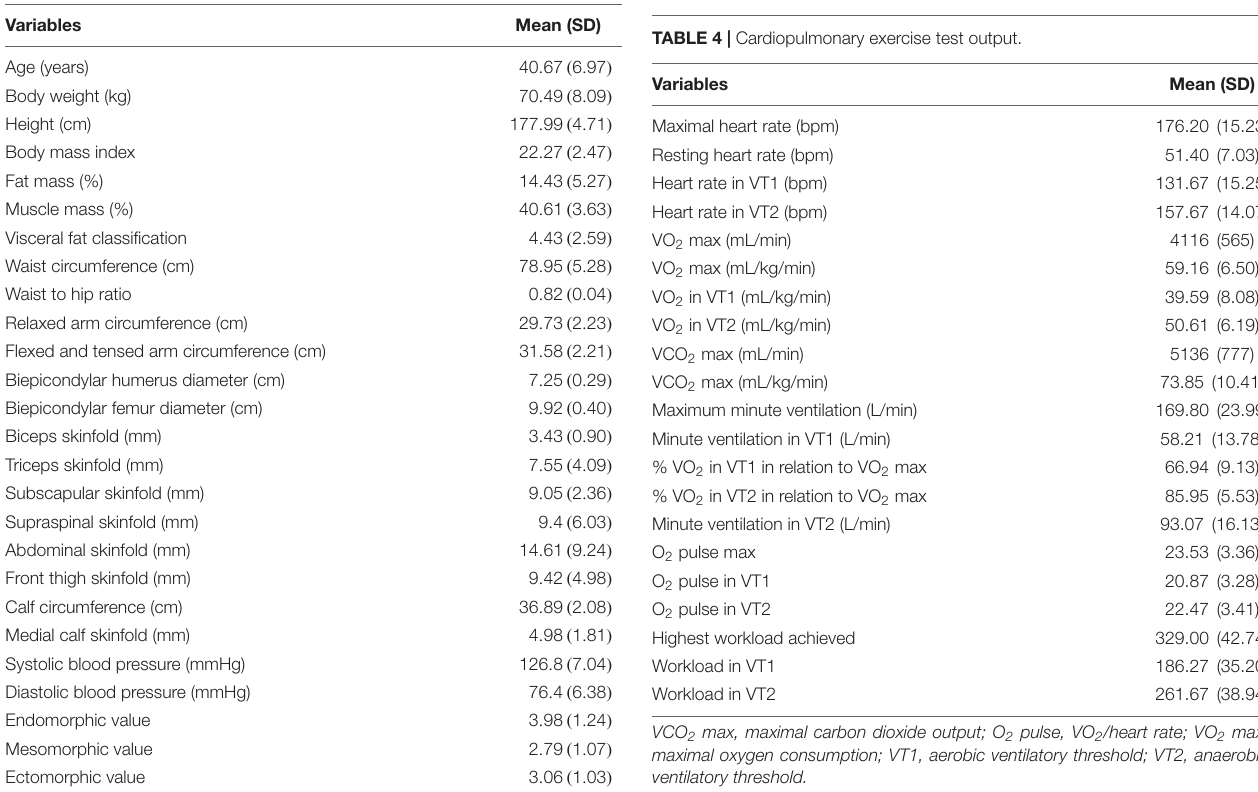
TABLE 2 | Anthropometric, body composition, somatotype and blood pressure variables.